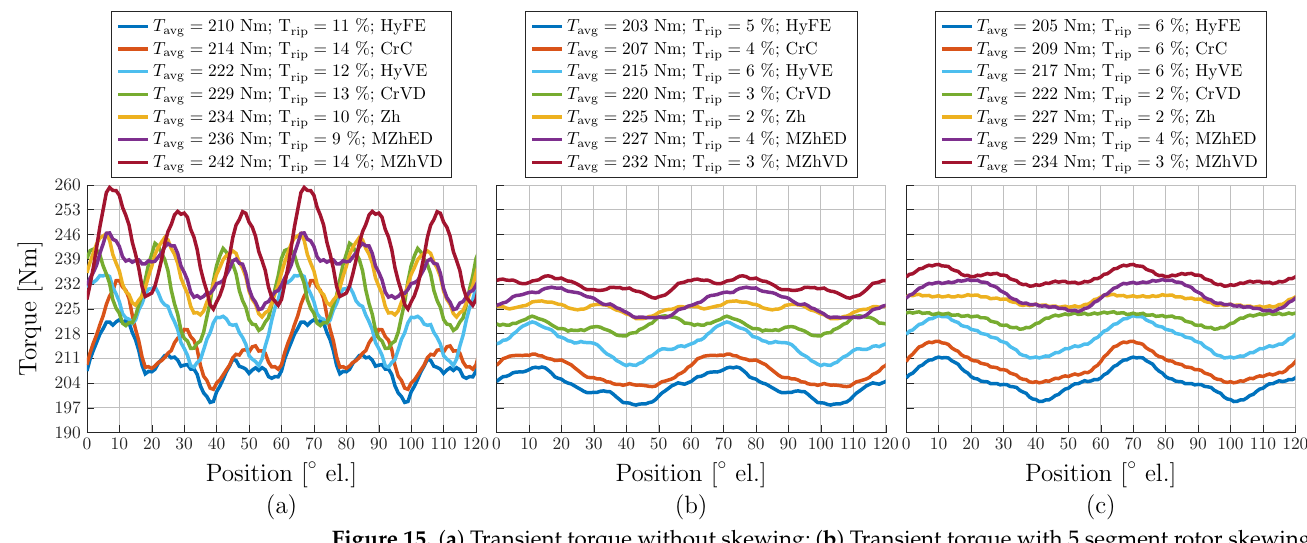
Figure 15. ( a ) Transient torque without skewing; ( b ) Transient torque with 5 segment rotor skewing; ( c ) Continuous